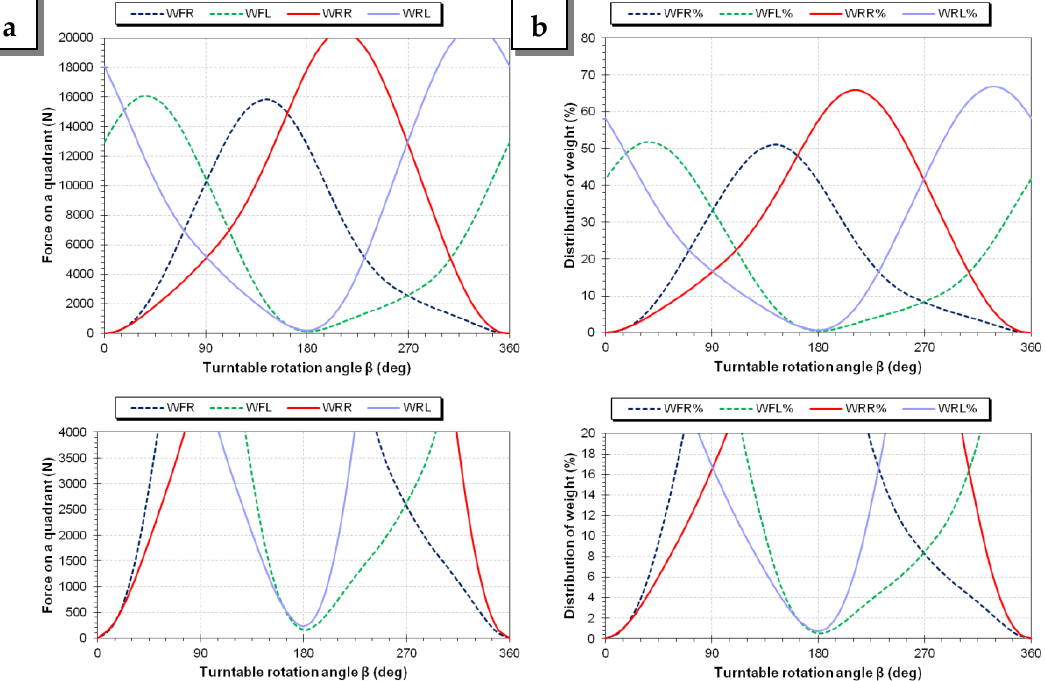
Figure 22. ( a ) forces normal to the four quadrants that support the vehicle during a complete rotation of the turntable for α = 33.95°; ( b ) percentage decomposition of the total weight on the four quadrants/wheels for α = 33.95°. In the lower part of the picture there are two enlargements of the Cartesian planes close to the abscissae axis.